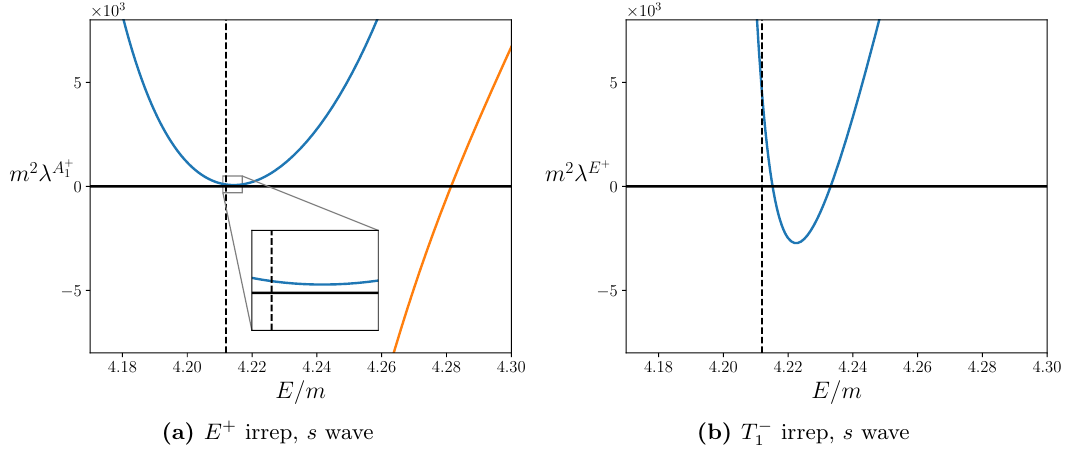
Figure 12. E(cid:11)ect of turning on all other parameters unchanged. Eigenvalues are now those of F (cid:0) 1